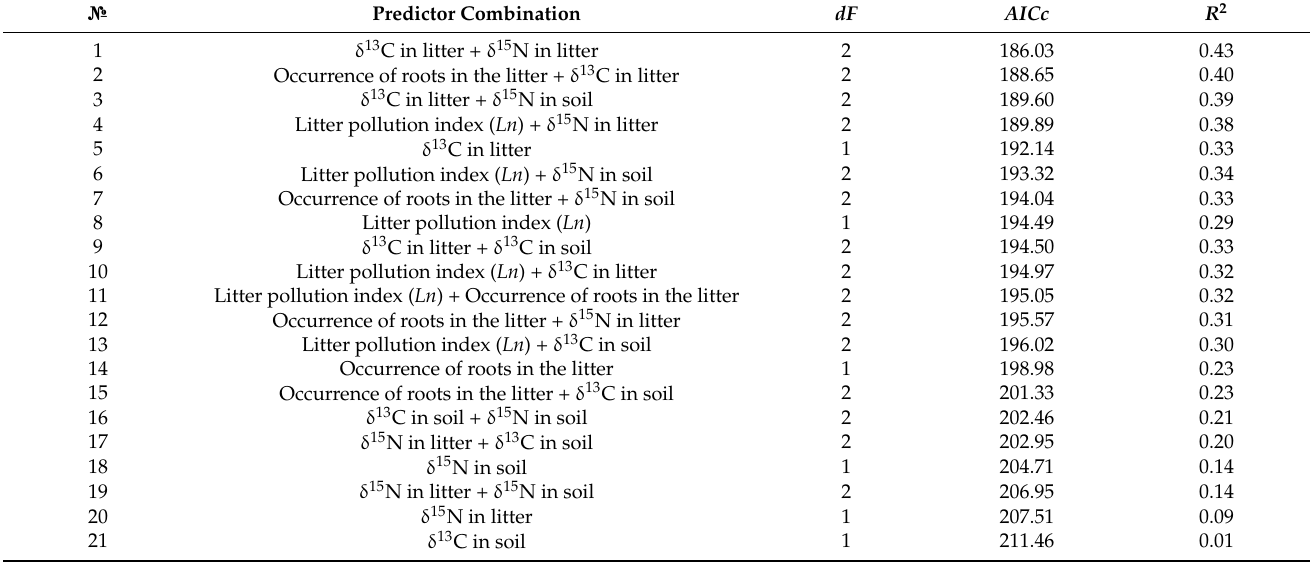
Table 2. The quality of GLM models explaining δ 15 N in tree leaves by the combination of different predictors. AIC с and R 2 estimates are given for the predictor combinations with dF equal to 1 or 2.